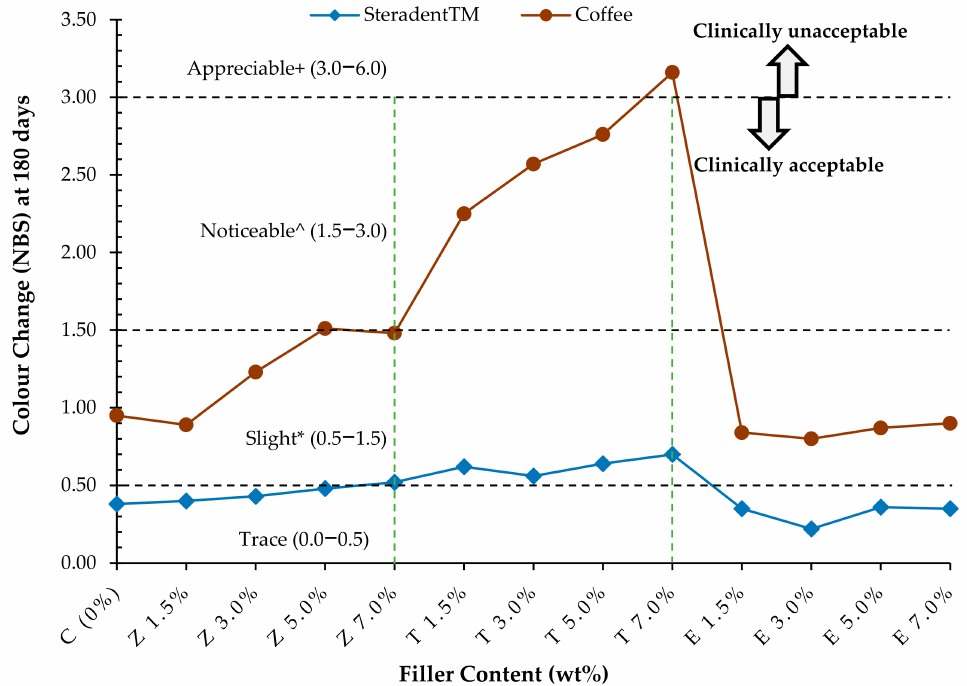
Figure 3. Line graph of the colour change observed (NBS unit system) in each group stored in Steradent™ and coffee for six